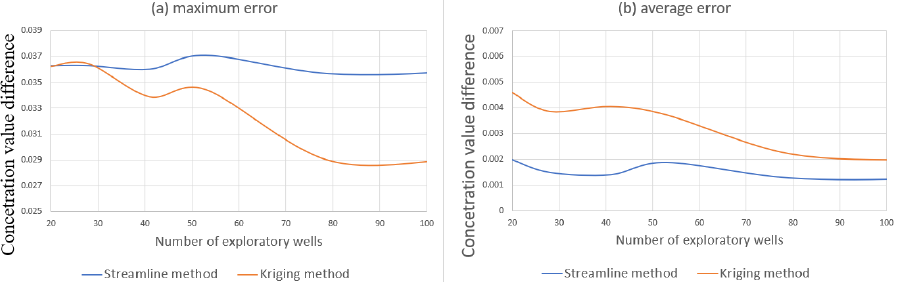
Figure 20. Errors in resource estimation comparison between streamline-based stochastic method and ordinary kriging where ( a ) maximum error from all nodes; ( b ) average error from all nodes.